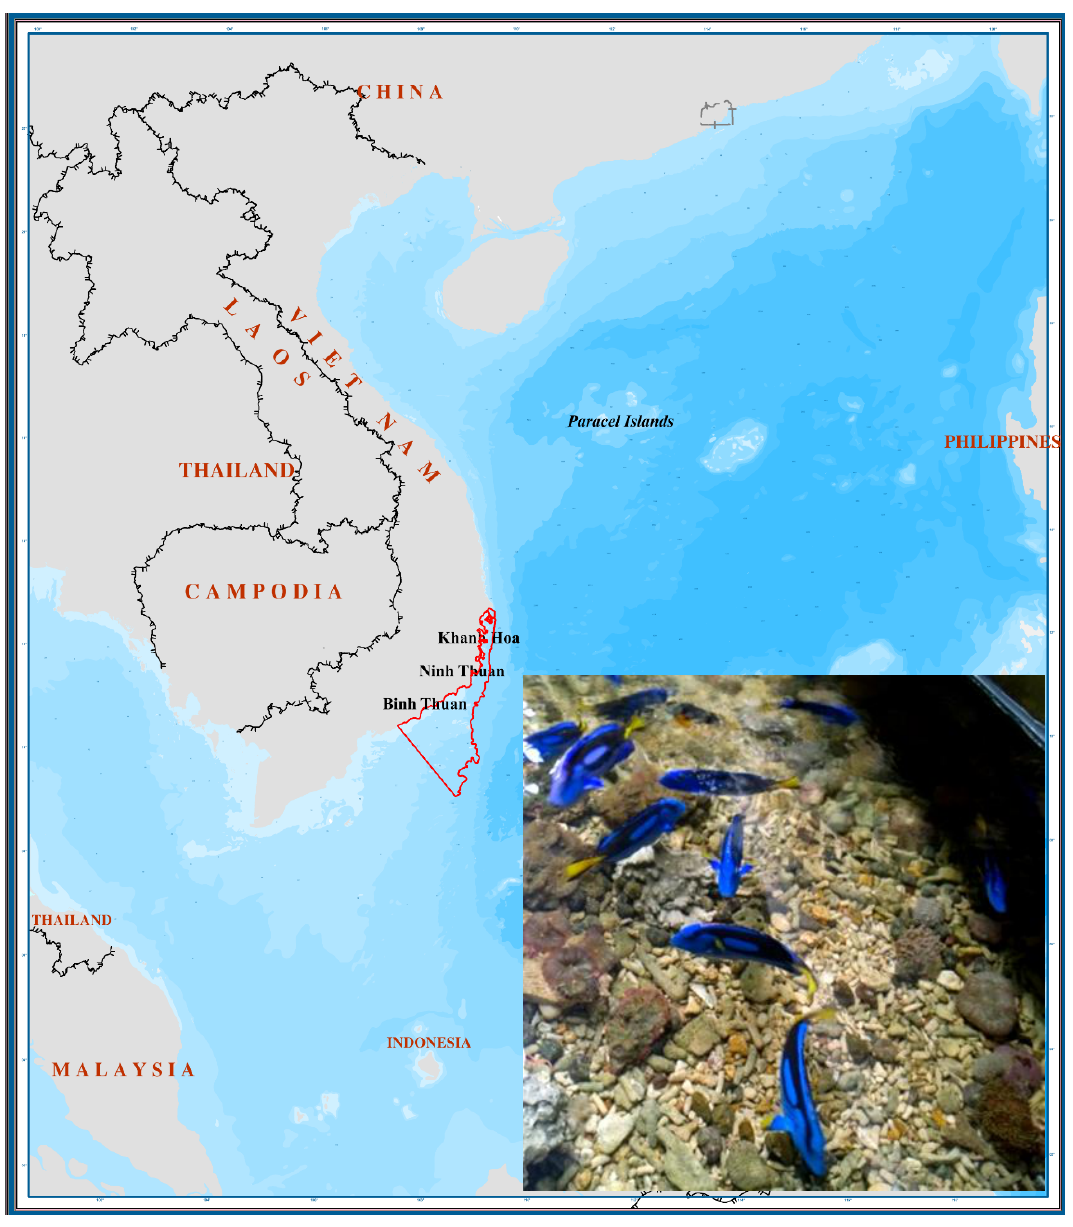
Figure 1. Studied map. Red boundary indicates the reefs from Khanh Hoa to Binh Thuan seawaters where live blue tang fish were collected. The small picture shows fish kept in the aquarium station at the Institute of Oceanography, Vietnam .